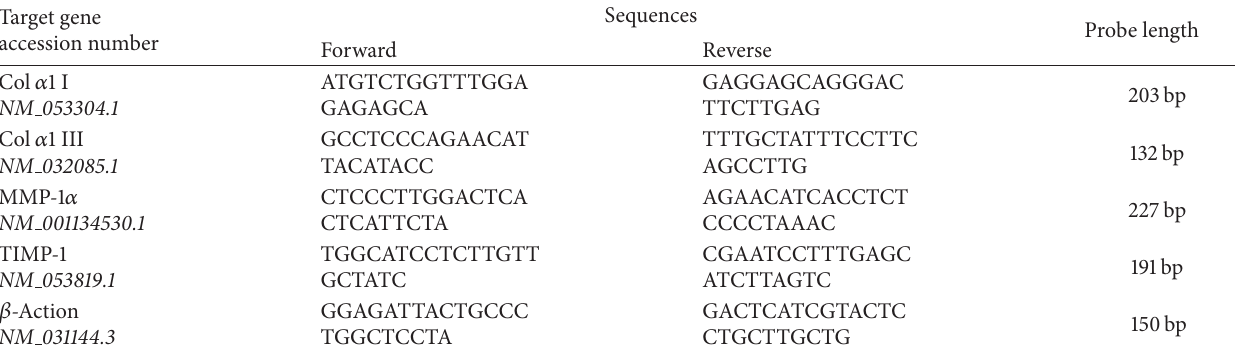
Table 2: Primer pairs for target and housekeeping genes for quantitative RT-PCR